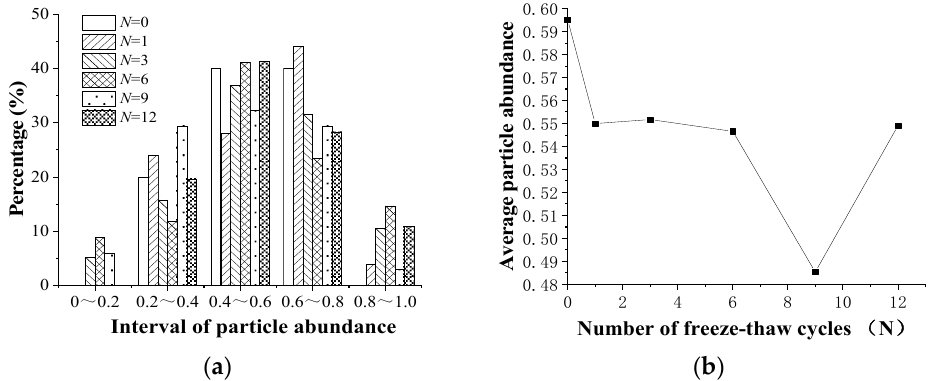
Figure 12. Particle abundance and average abundance under different freeze–thaw cycles. ( a ) Grain abundance. ( b ) Average abundance of particles. abundance. ( b ) Average abundance of particles.